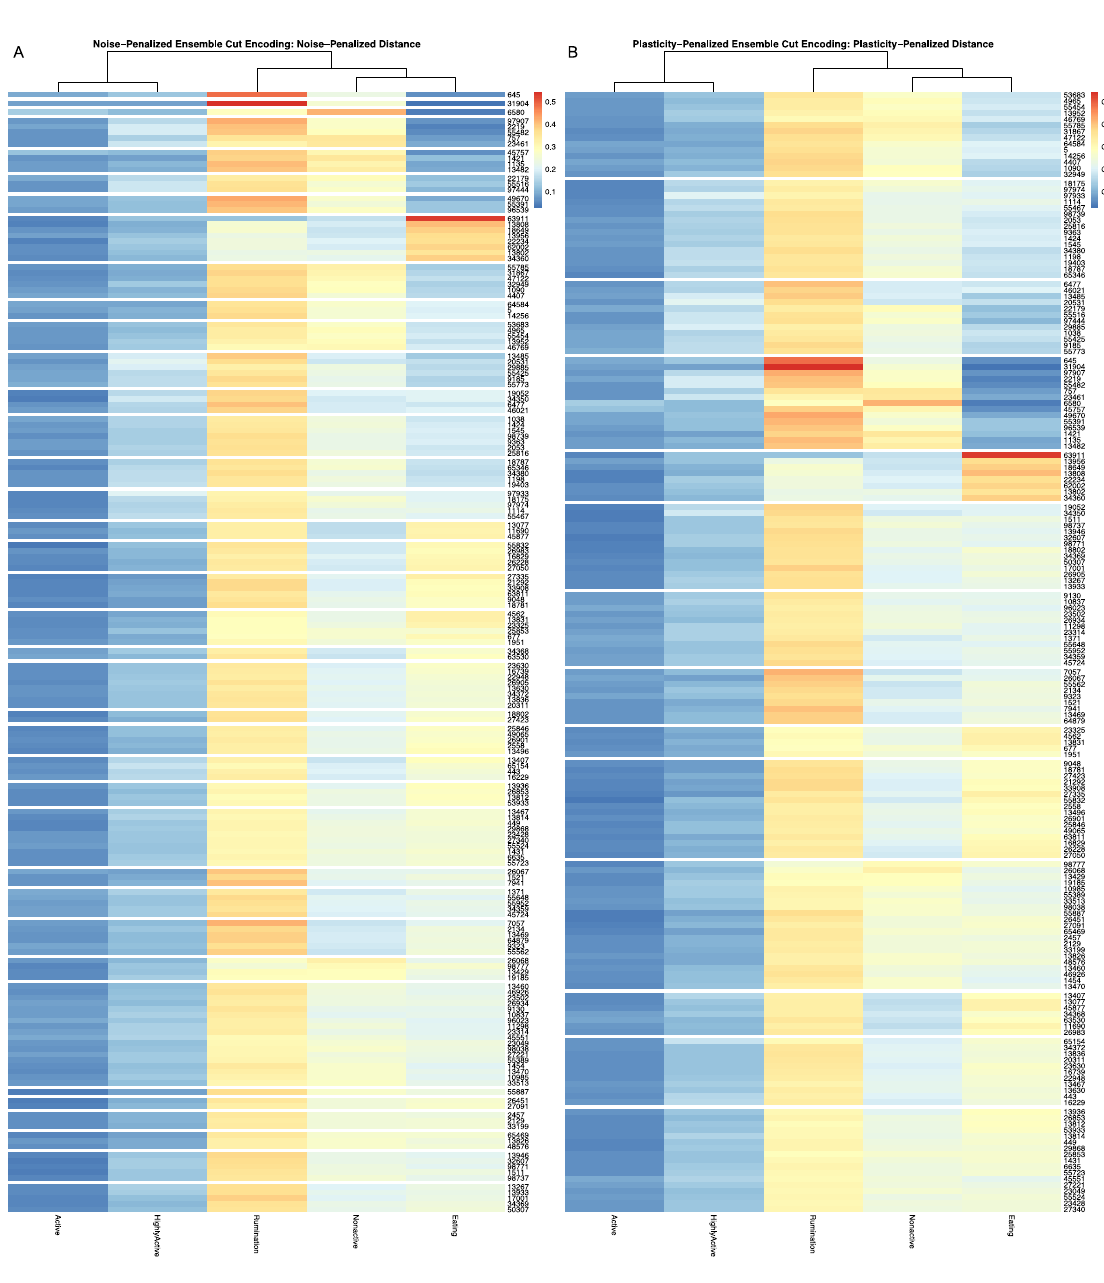
Figure 4. Encodings produced by the cutreeEnsemble algorithm. ( A ) Dendrogram produced by the noise-penalized ensemble weighted dissimilarity metric cut using the noise-penalized data mimicry. The extremely fine encoding with 38 stochastically validated clusters demonstrates that, with so many recorded observations over this extended observation window, the accuracy of the sensor itself should impose few constraints on our behavioral inferences. ( B ) Dendrogram produced by the plasticity-penalized ensemble weighted dissimilarity metric cut using the plasticity-penalized data mimicry. A courser encoding is returned when uncertainty in time budget observations attributable to the behavioral plasticity of the animal itself is taken into consideration.